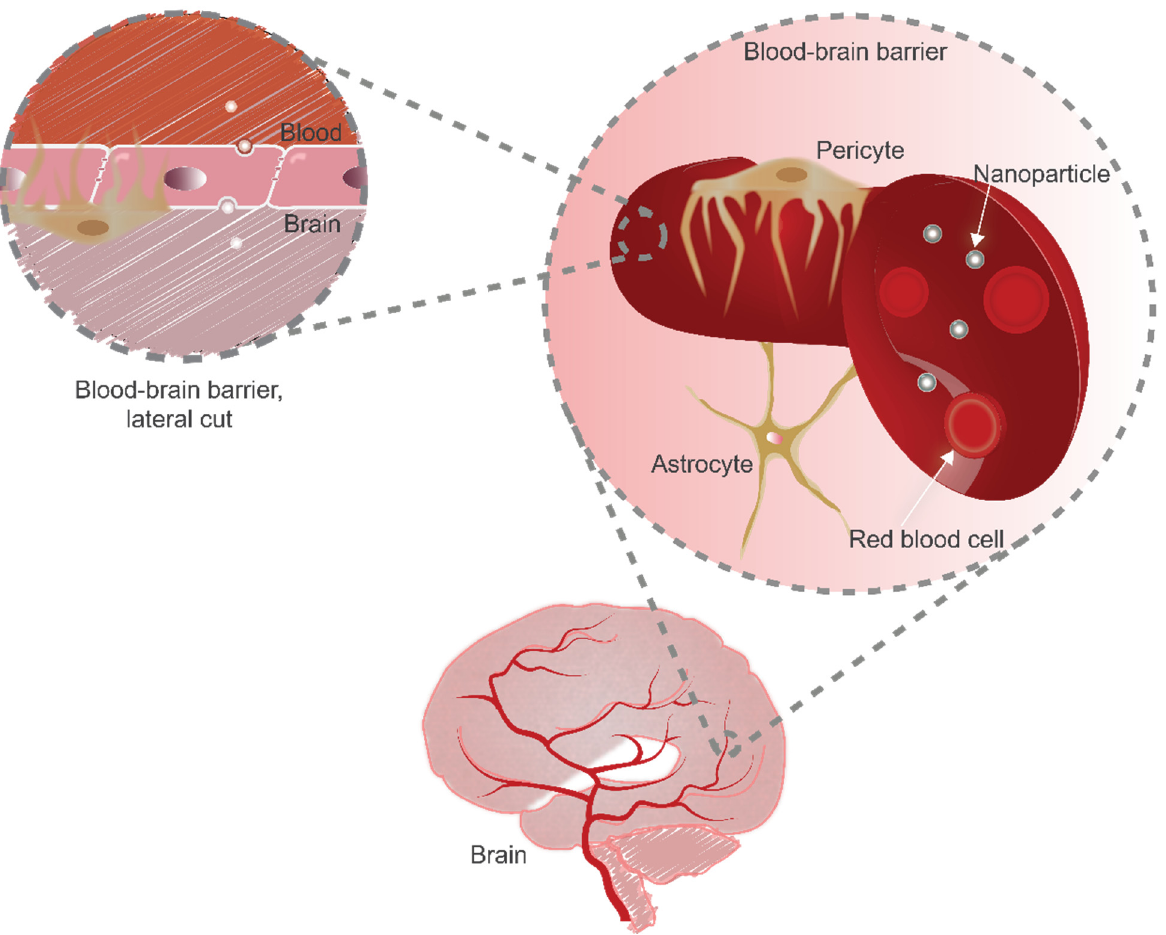
Figure 1. Blood–brain barrier representation. The brain capillaries irrigate the brain parenchyma, and their structure is composed of specialized endothelial cells as well as pericytes and astrocytes. The endothelial cells display apical–basal polarity, and tight junctions separate the polarized membranes. To reach the brain, NPs will need to interact with the apical membrane, be internalized by the endothelium, and undergo vesicular trafficking and exocytosis.